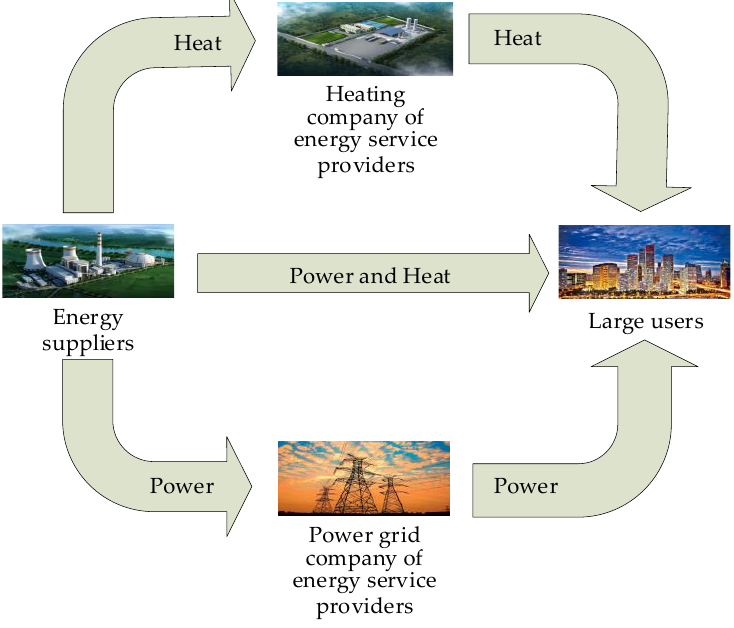
Figure 1. Energy internet market structure.